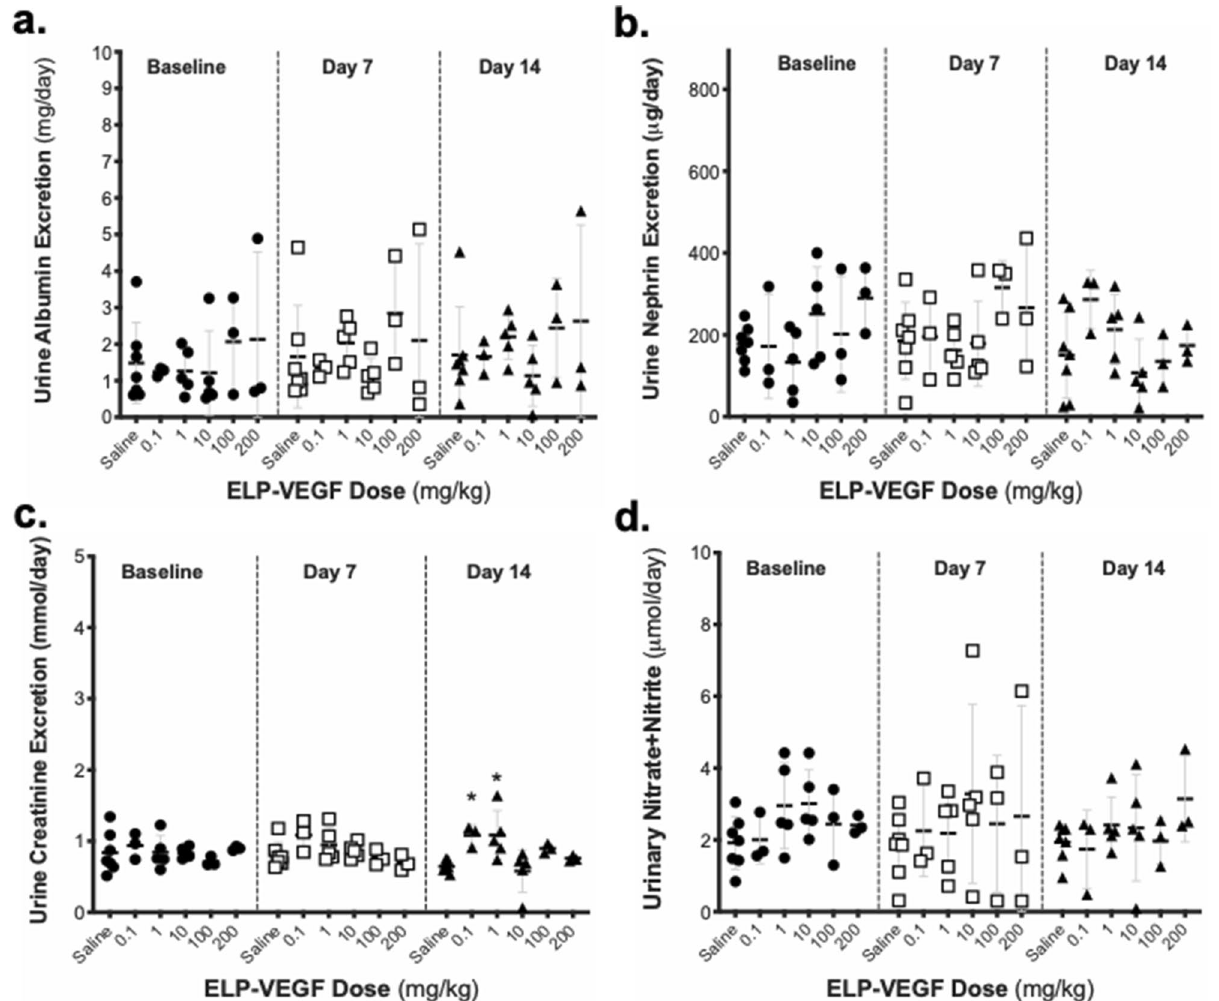
Figure 4. Effect of ELP-VEGF on Urinary Markers of Renal Function and Injury. 24-h urine samples were collected by metabolic cage housing prior to treatment and 7 and 14 days after treatment with ELP-VEGF at increasing doses. (a) Albumin excretion and (b ) urinary nephrin excretion were determined by ELISA to assess renal injury. (c) Urine creatinine excretion was determined using a Vet AXCEL chemistry analyzer, and (d) urinary nitrate/nitrite excretion was determined by chromogenic assays to assess nitric oxide production. * Statistically significant increase relative to saline treated rats, two-way ANOVA with post-hoc Dunnett correction for multiple